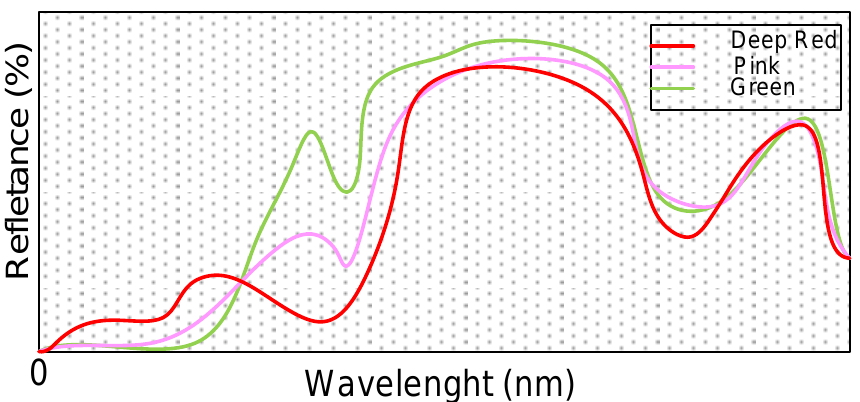
Figure 8. Identification of the maturity of tomato using spectroscopy (NIR) from Li et al.